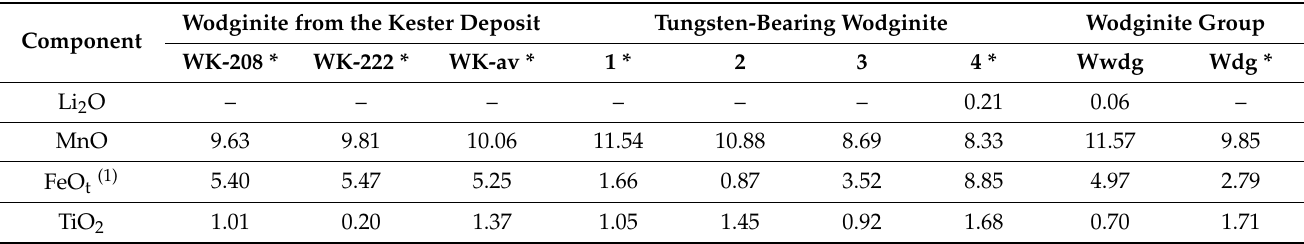
Figure 2. BSE images of wodginite from lithium-fluoric granites from the Kester deposit (East Yakutia): ( a , c ) Euhedral W-bearing columbite-(Mn) with a rim of aggregated W-bearing tantalite- (Mn), wodginite, and microlite. ( b , d ) Details of Figures a, c: rim of complex aggregate formed by tantalite-(Mn), wodginite, and microlite in columbite-(Mn). ( e ) Subhedral tantalite-(Mn) with a nucleus of columbite-(Mn) and a rim of a complex aggregate made of tantalite-(Mn) and W-bearing wodginite. ( f ) Partial pseudomorphs of tantalite-(Mn) and wodginite after crystals of tungsten- bearing columbite-(Fe) that form a solid aggregate with Nb-bearing cassiterite. Indices of minerals were taken from Warr (2021) [28]. Table 1. Chemical composition (wt%) of tungsten-bearing wodginite in Li-F granites from the Kester deposit and other deposits across the